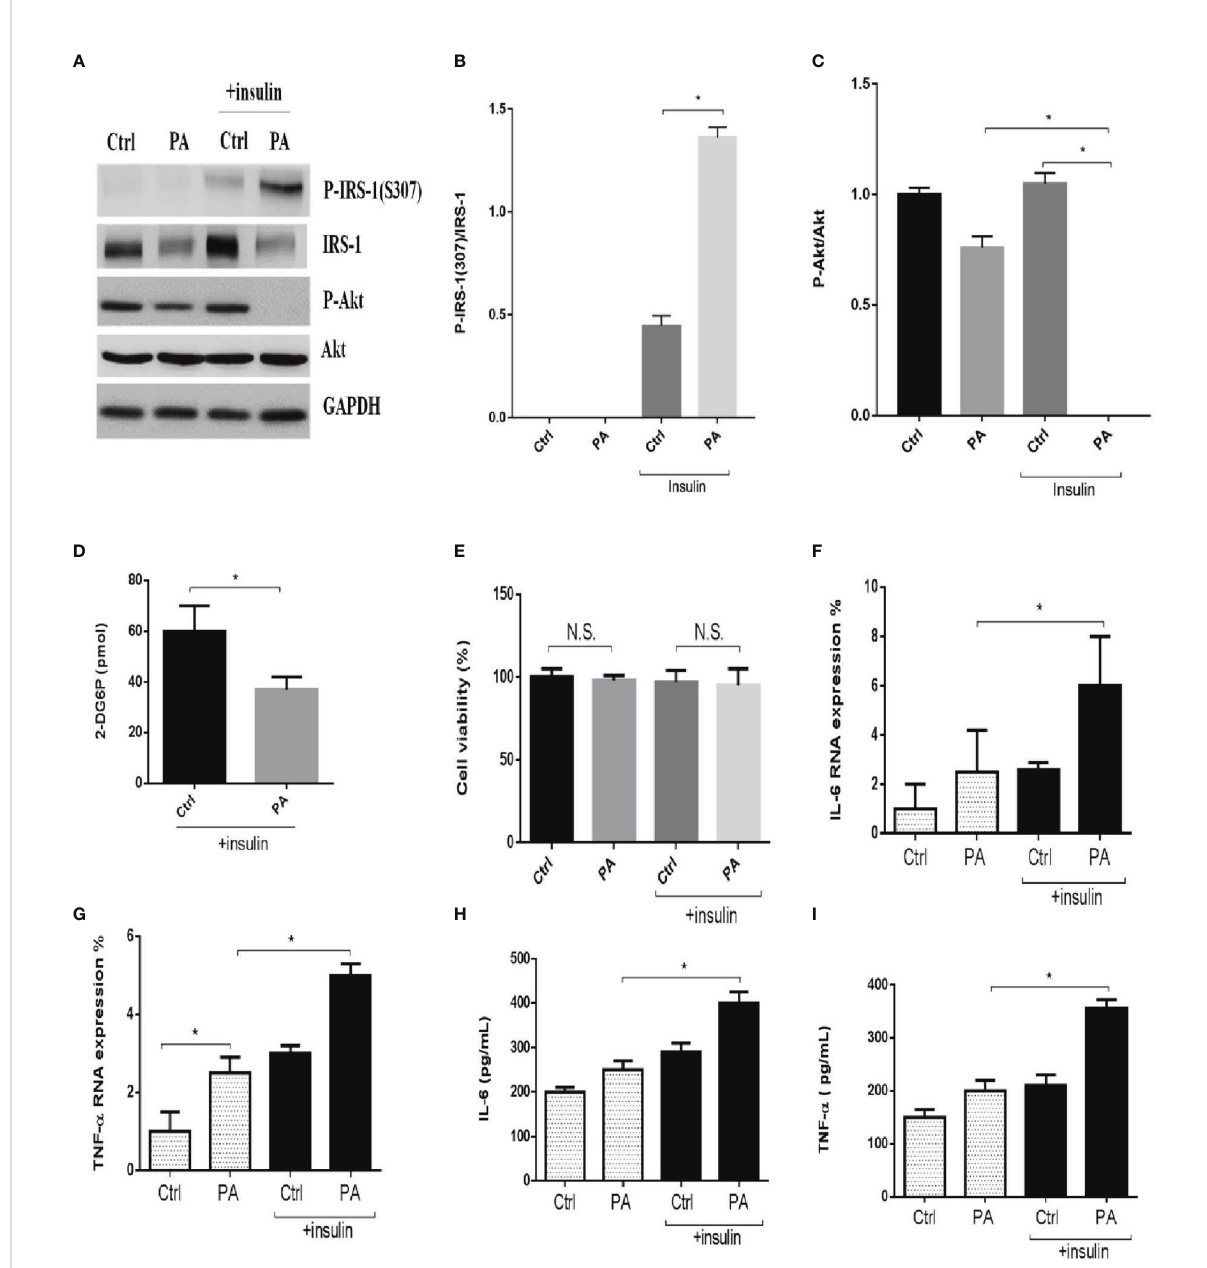
FIGURE 1 Palmitate disturbed insulin signaling and glucose uptake and increased in fl ammatory cytokines in C2C12 cells. The C2C12 myotubes treated with 0.6 mM of palmitate (PA) with or without 100 nM insulin, then estimated p-IRS-1(307), p-Akt by western blotting (A-C) and 2-Deoxyglucose (2-DG) uptake was assessed (D) . In addition, cell viability was measured by MTT (E) . The levels of (F, G) IL-6, TNF- a were analyzed by real-time PCR, (H, I) IL-6, TNF- a were analyzed by ELISA after C2C12 myotubes treated with 0.6 mM of palmitate (PA) with or without 100 nM insulin. All data are presented as the mean ± SD (n = 3 for each group); *P < 0.05. N.S, no signi fi